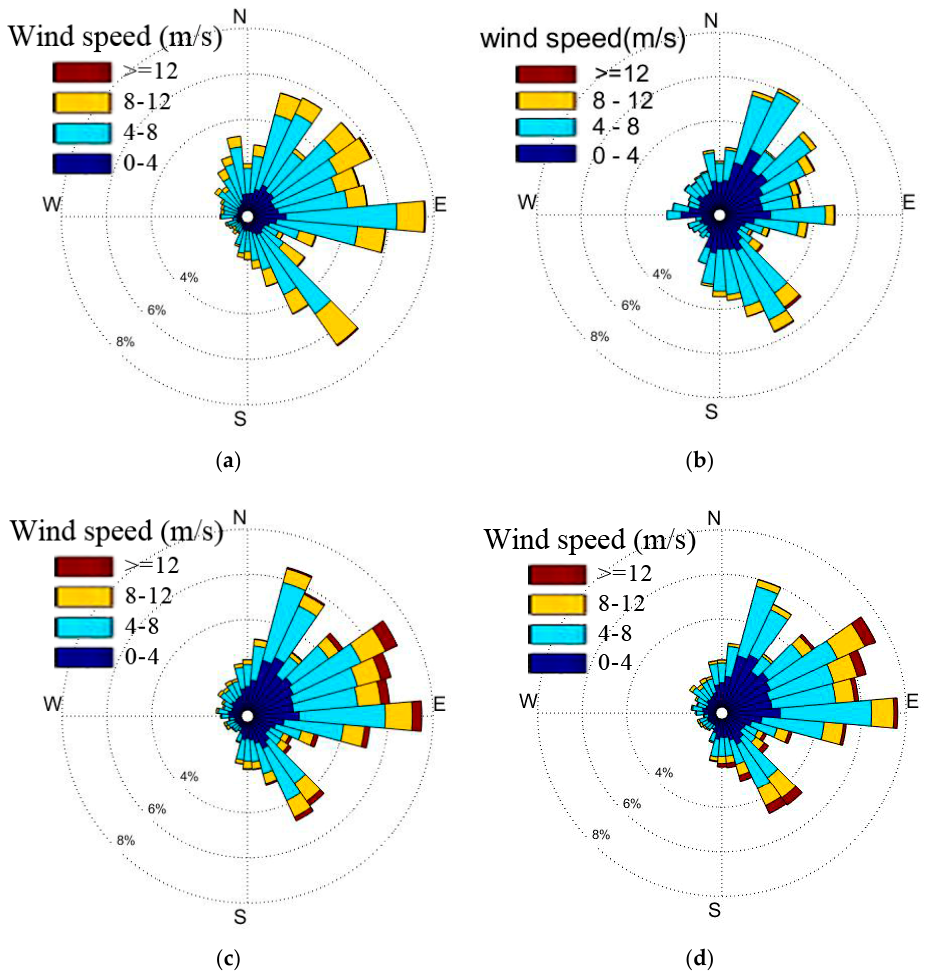
Figure 3. Wind roses: ( a ) spring; ( b ) summer; ( c ) autumn; ( d ) winter.